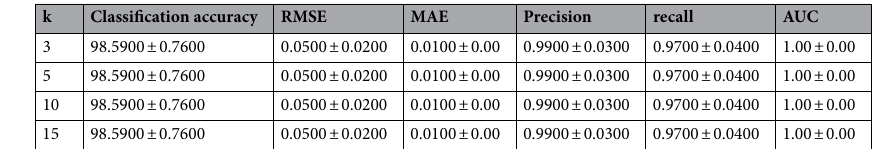
Table 6. Mean values and standard deviation of model performances on the male